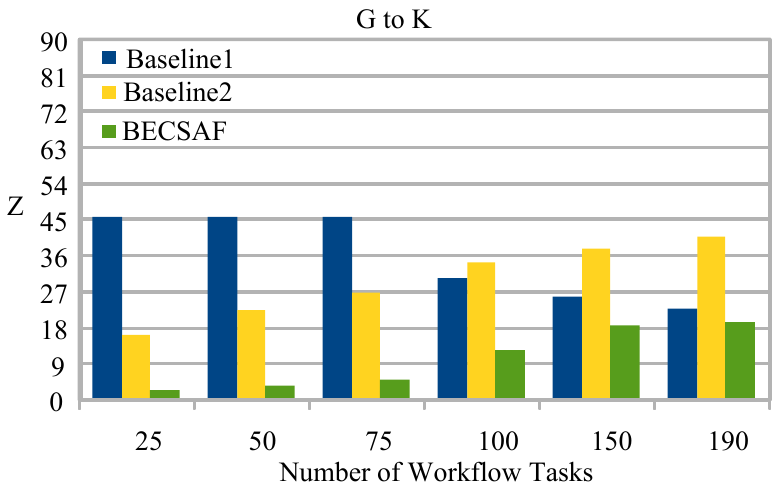
Figure 6. Cost of Failure Between User Application G to Request Computing Node K